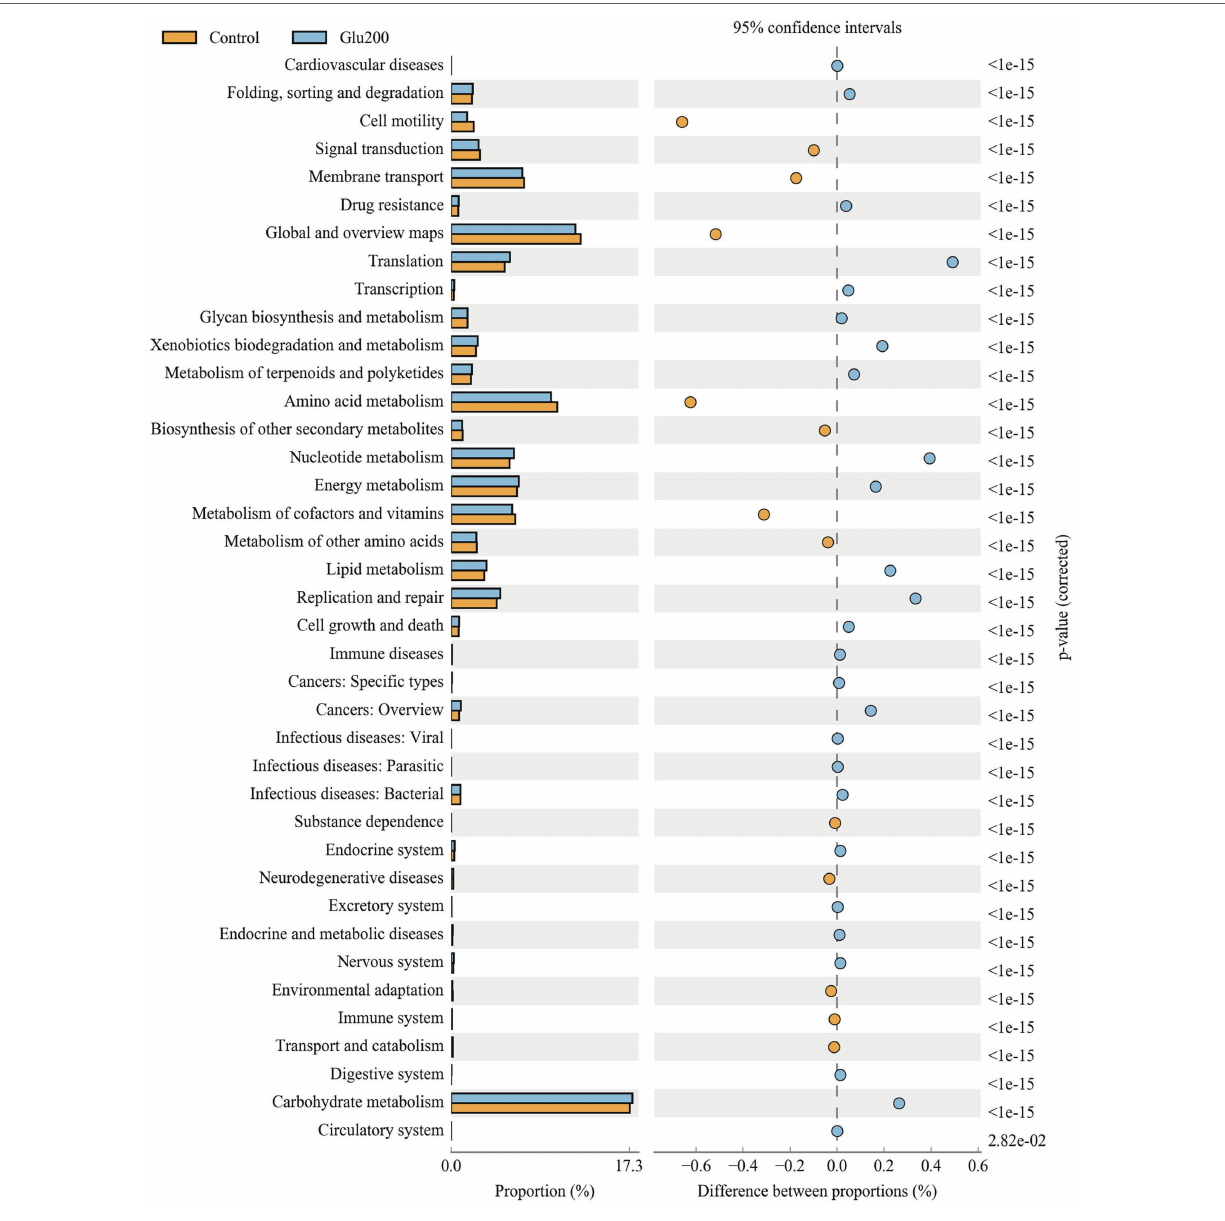
FIGURE 3 | Microbial function prediction in the ileum of breeder laying hens fed with or without dietary Glu200. The second level of the KEGG pathway is shown in the extended error bar. The value of p are shown to the right. Control: the basal diet; Glu200: the basal diet supplemented with 200 mg/kg yeast β